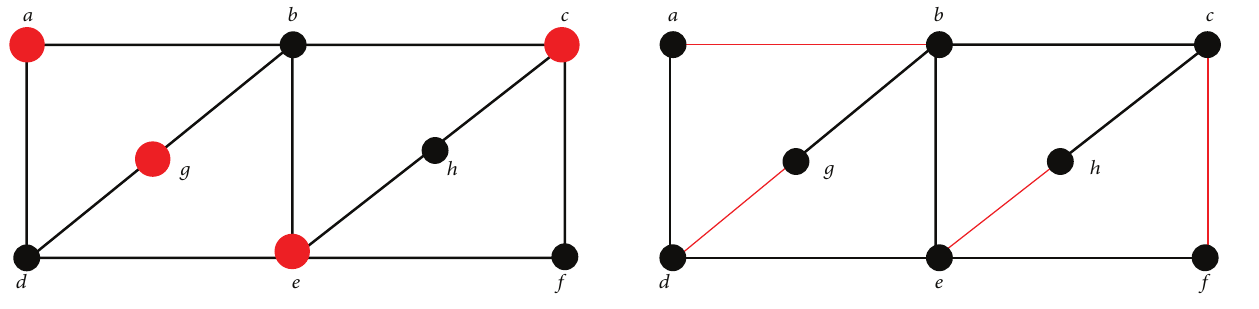
Figure 3: Maximal independent set. Figure 4: A maximal